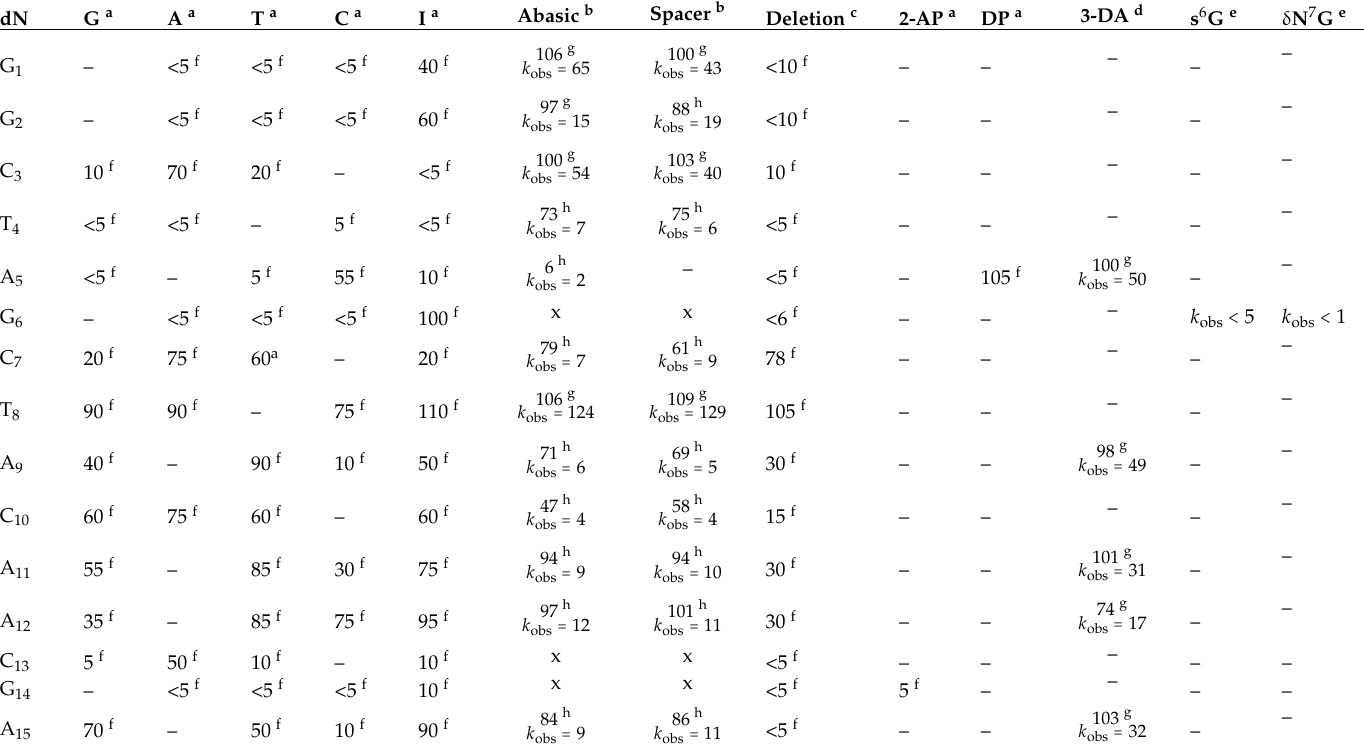
Table 2. Effect of selected substitutions of single deoxynucleotides on the activity ( Y t and k obs ) of the 10-23 DNAzyme towards short RNA substrates. Parameters were reported for reactions performed in the presence of tenfold excess [70,72] or in the presence of 100-fold excess of the DNAzyme over the RNA substrate [65], and in the presence of 100- to 200-fold excess of the DNAzyme over a chimeric DNA/RNA substrate [66,69]. Unless specified differently, the values refer to Y t . If values refer to k obs this is explicitly mentioned. “–” indicates that this modification was not investigated on this position, “x” indicates that no yield Y t could be measured for this modification. All values are given in percentages compared to the substrate cleavage performed by the unmodified DNAzyme; that is, k obs = 100 ⋅ k obs, mutant / k obs, wild-type and Y = 100 ⋅ Y t , mutant / Y t , wild-type